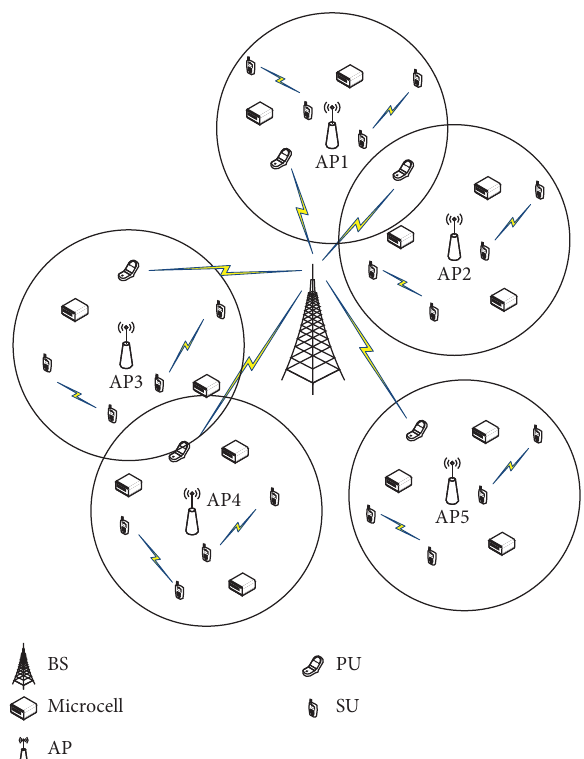
Figure 1: The system model of